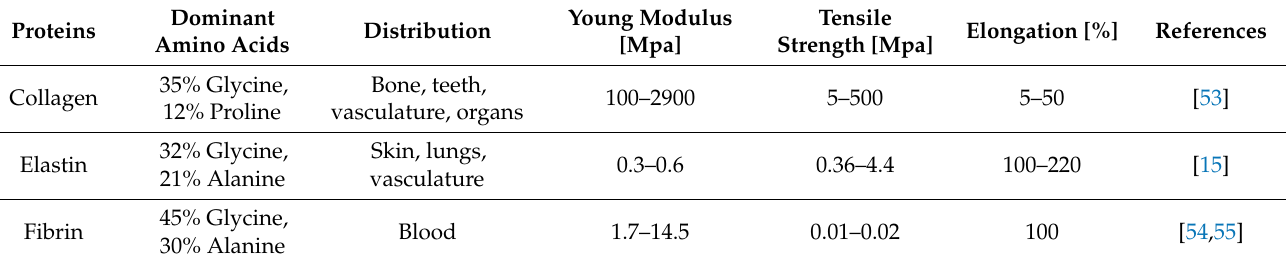
Table 1. Mechanical properties of selected proteins.